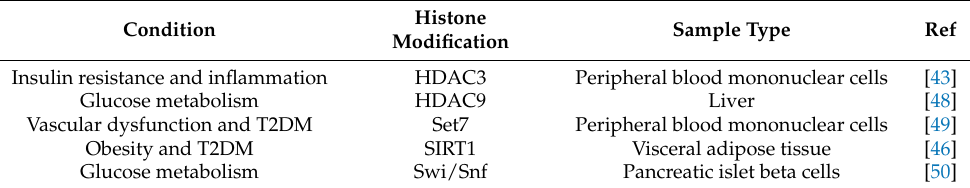
Table 2. Human studies showing associations between histone modifications and features of metabolic